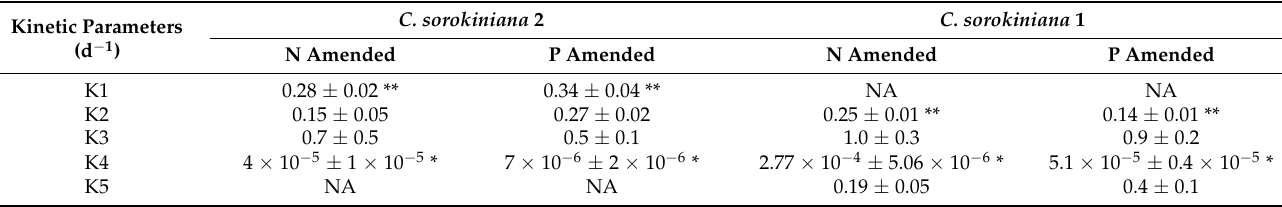
Figure 4. Pathway involved in the present study for lipid formation. Table 8. Kinetic coefficients of the interconversion of various fatty